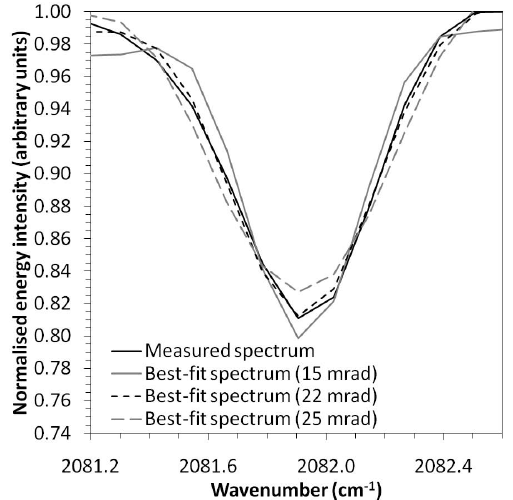
Fig. 6. Measured single-beam spectra and best-fit modelled spectra for the CO absorption line centred at 2082cm − 1 at a gas pressure of 400.5hPa. Modelled spectra were simulated assuming different fields-of-view (15–25mrad), with the 22mrad FOV providing the best match between the measured and modelled